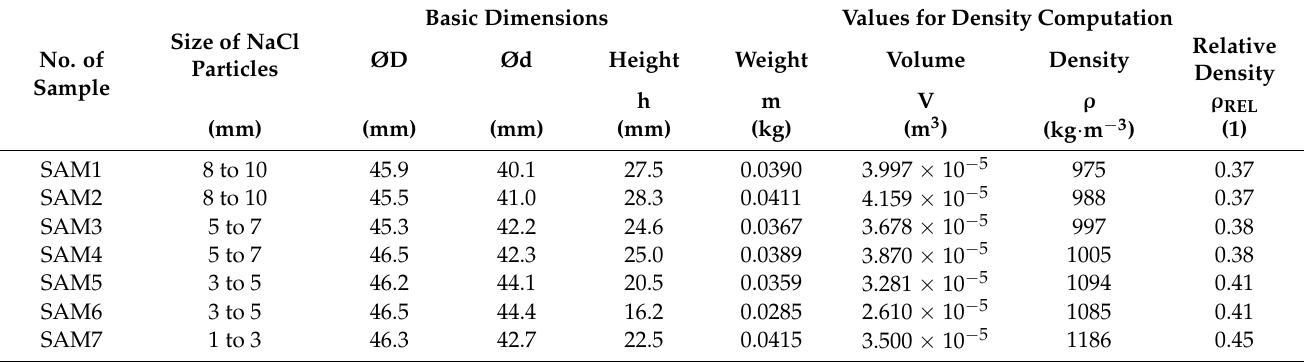
Table 4. Basic dimensions and density of produced samples from aluminum porous